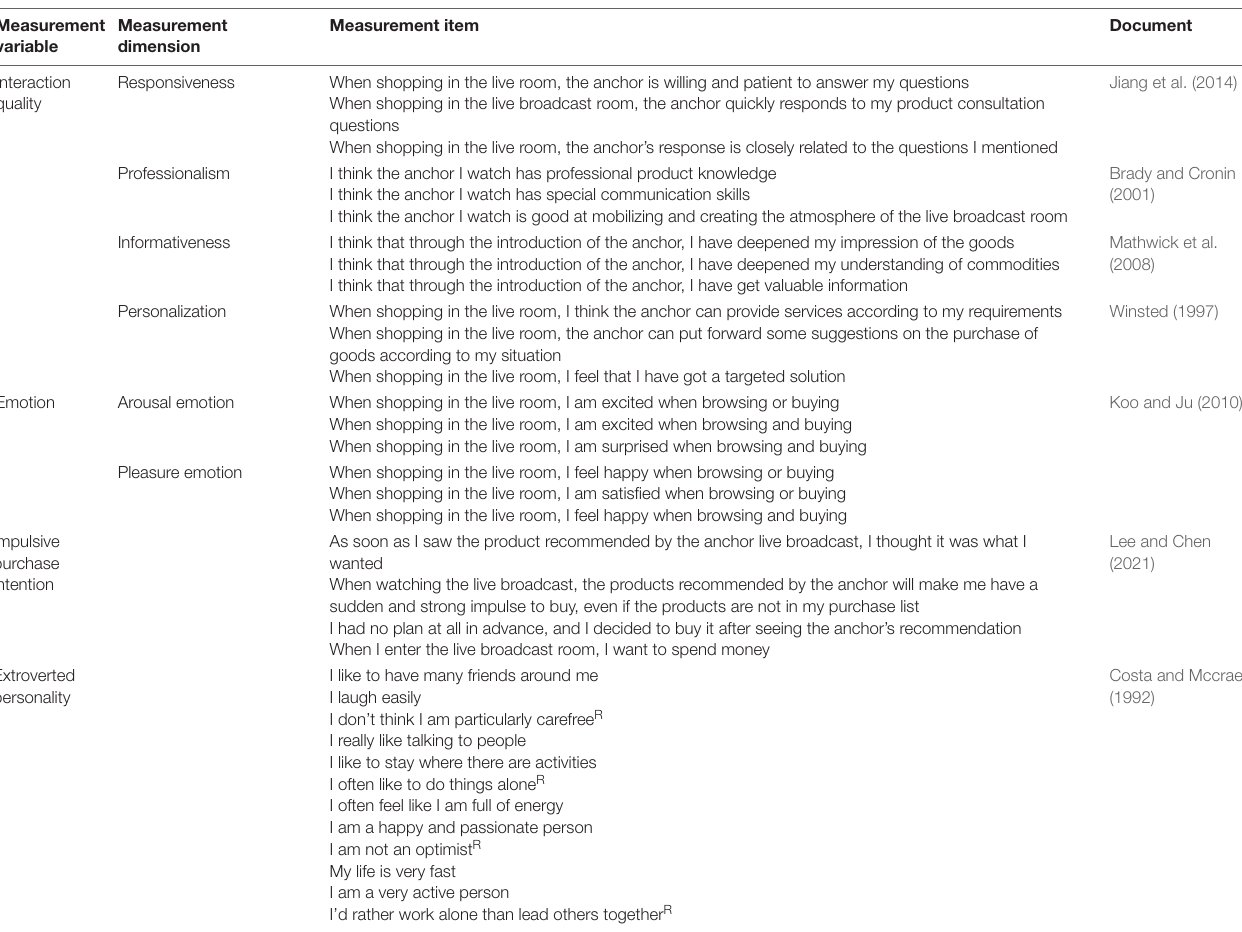
TABLE 1 | Variablew measurement items ( N =